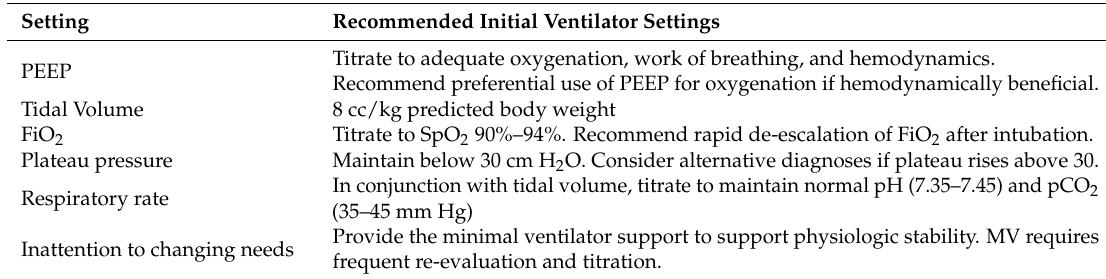
Table 1. Recommended ventilator settings for patients with heart failure with reduced ejection